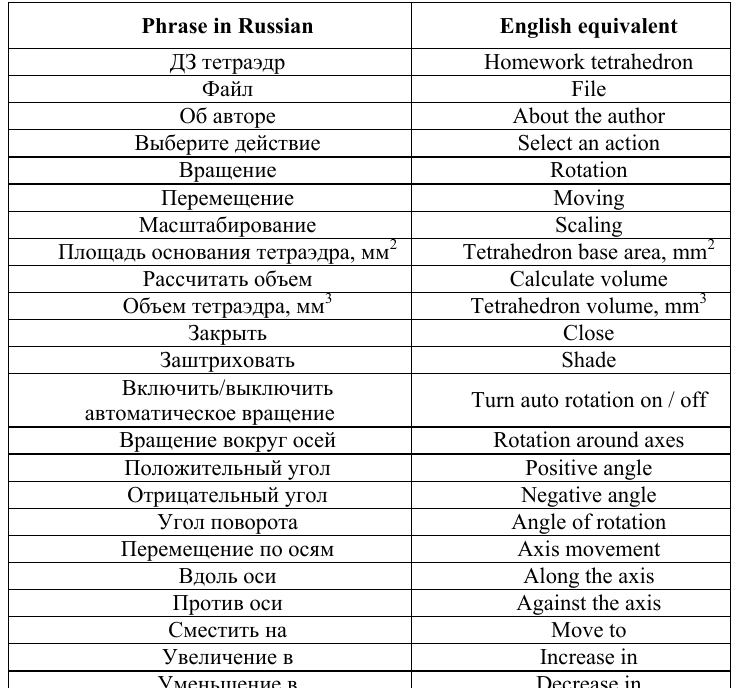
Fig. 6. An example of an implementation of a geometric modeling task. Table 1 . Contains of Figure